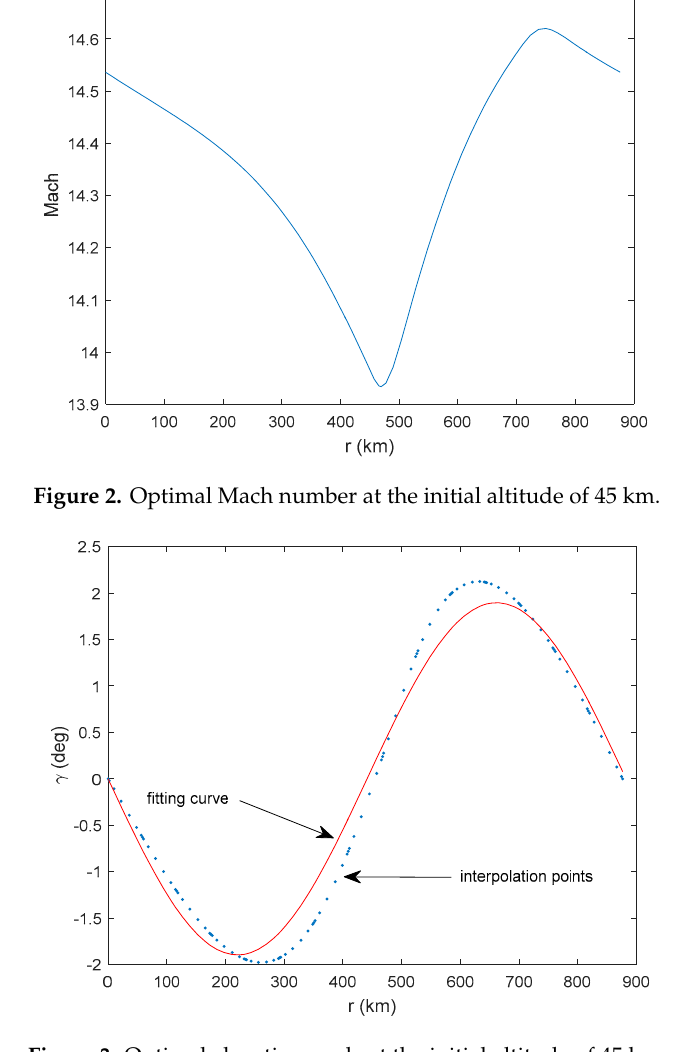
Figure 4. Optimal angle of attack at the initial altitude of 45 km.